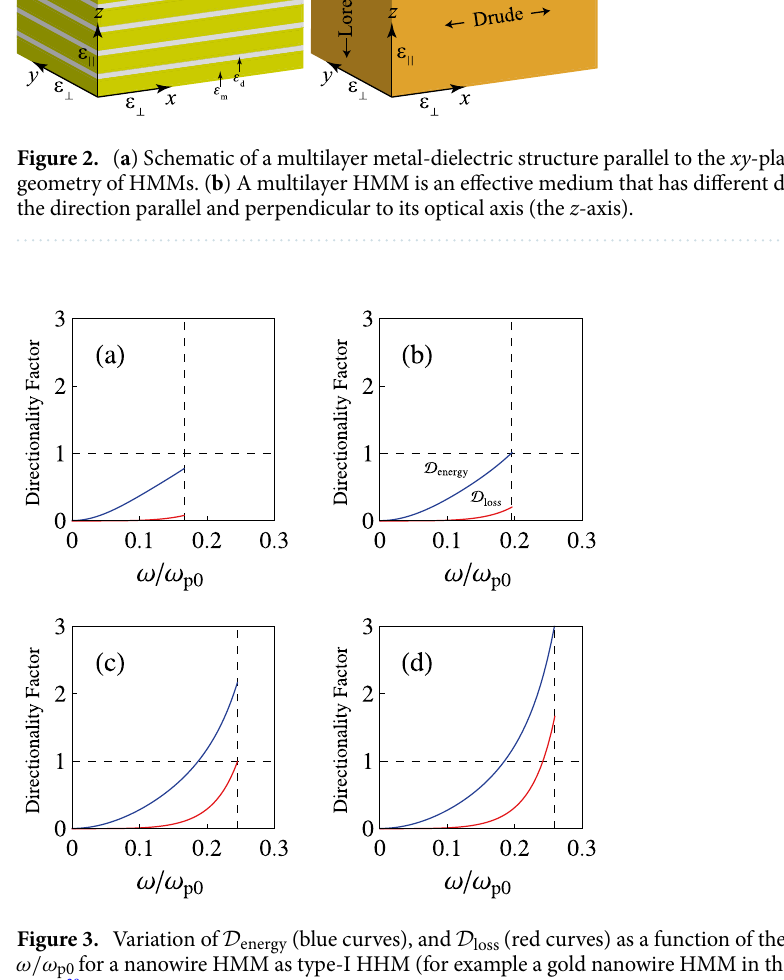
1 , and γ 0.01 ω p0 . The vertical = ∞ = 0.1 , ( b ) f 0.135 , ( c ) f 0.2 , and = = =